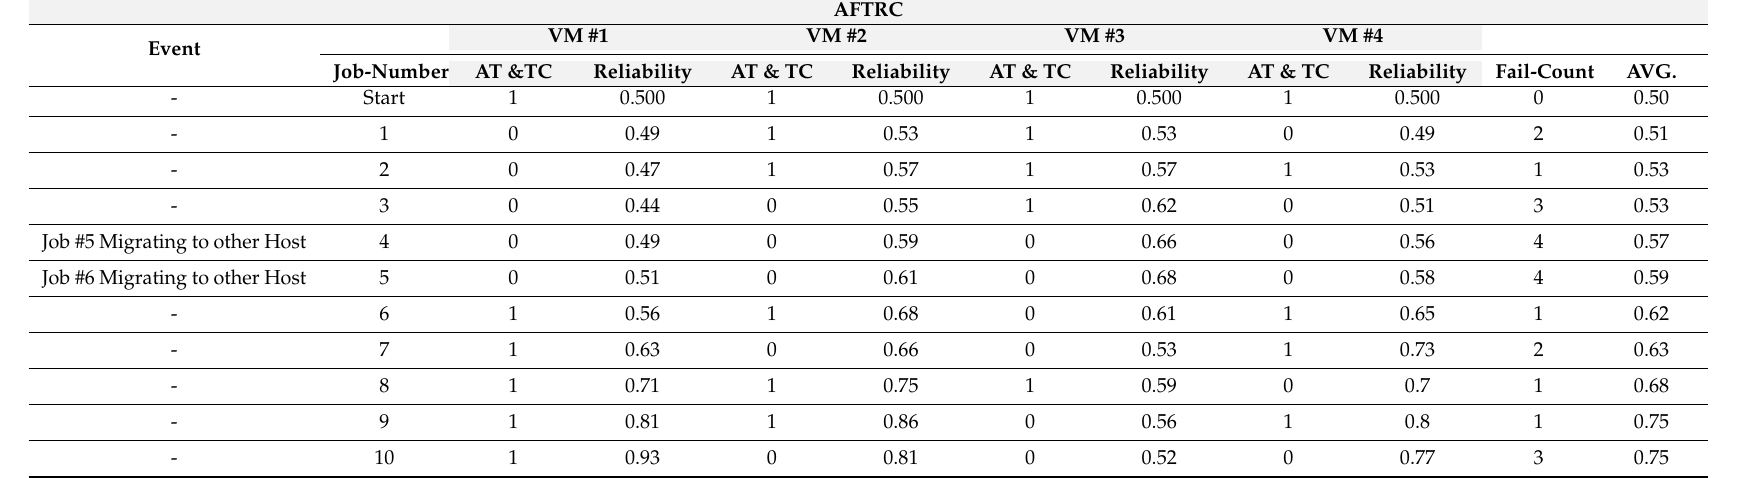
Table 6. Results of simulating AFTRC in